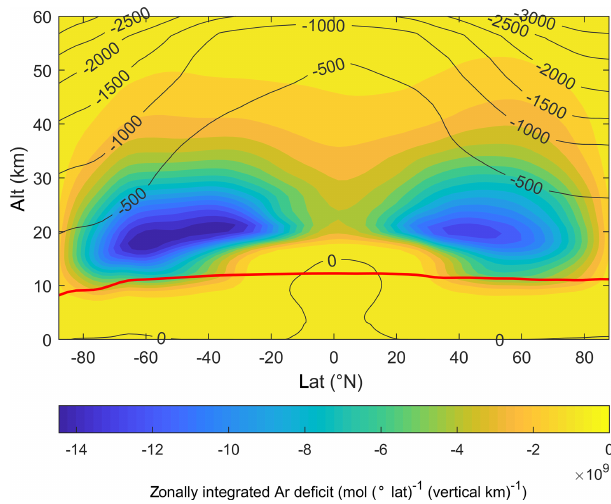
Figure 7. Color map of annual mean and zonally integrated Ar deficit in TOMCAT. Overlain black contour lines show δ( Ar / N 2 ) (per meg). The red solid line highlights the mean position of the 200hPa